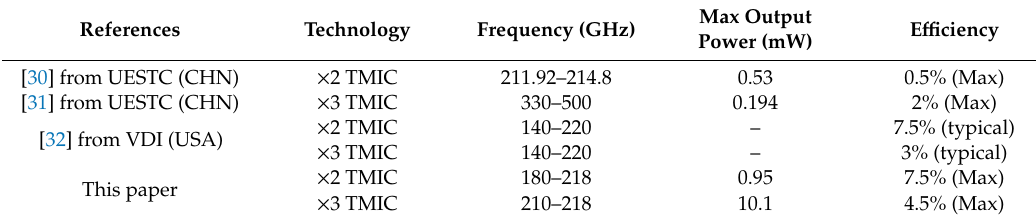
Table 2. Performance comparison of the frequency multipliers based on